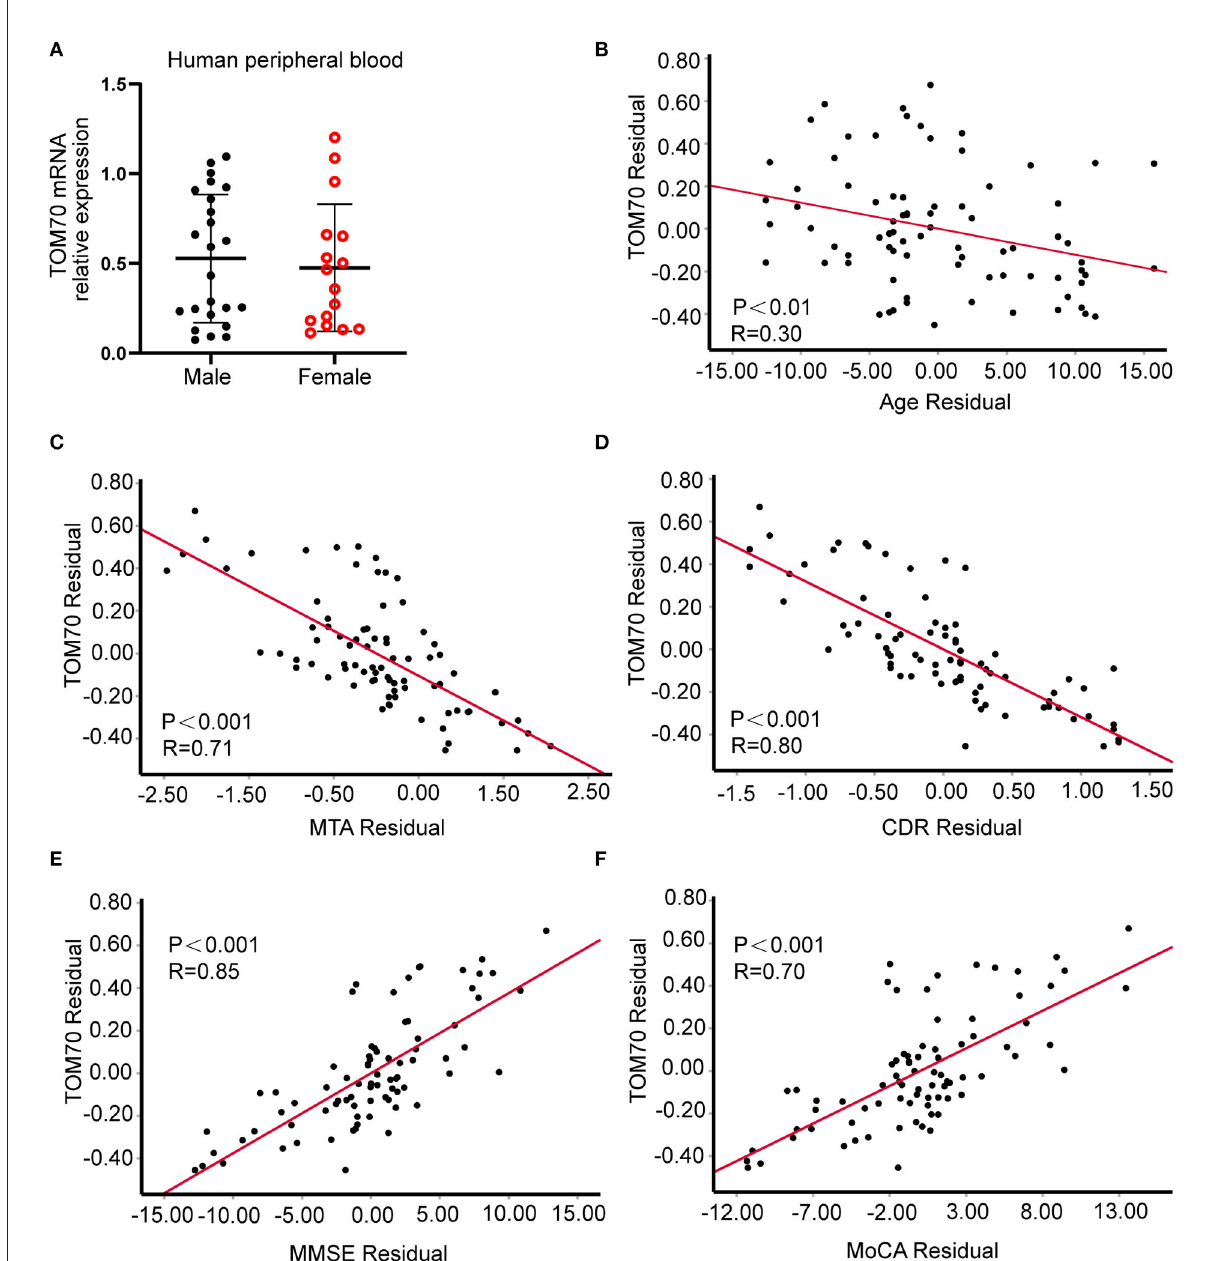
FIGURE3 Partial correlation between TOM70 and variables. CDR score positively correlates with AD severity. MMSE and MoCA scores negatively correlate with AD severity. (A) A scatter plot of TOM70 per sex group. (B) Correlation of TOM70 and age adjusted for diagnosis and sex. (C) Partial correlation between Tom70 and MTA score adjusted for age, diagnosis, and sex. (D) Partial correlation between Tom70 and CDR score adjusted for age, diagnosis, and sex. (E) Partial correlation between Tom70 and MMSE score adjusted for age, diagnosis, and sex. (F) Partial correlation between Tom70 and MoCA score adjusted for age, diagnosis, and sex. n = 40 (AD) and 40